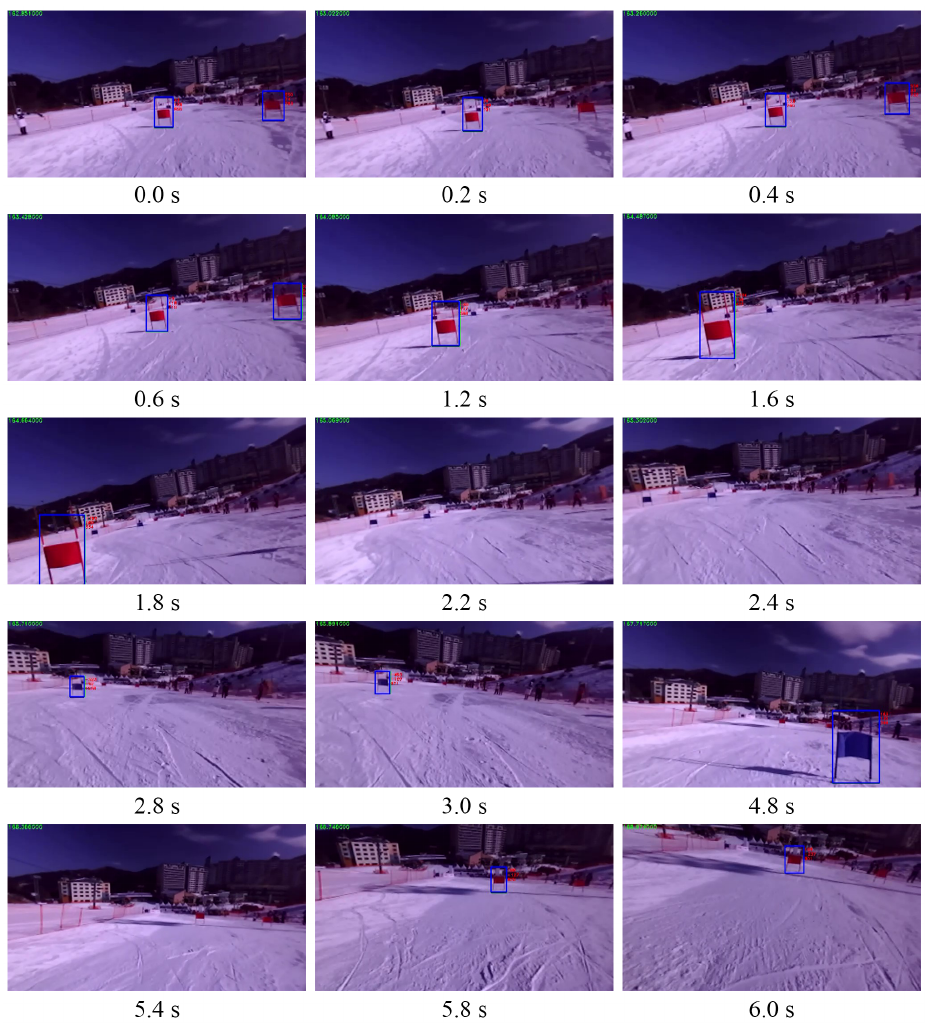
Figure 16. Recognition result of skiing